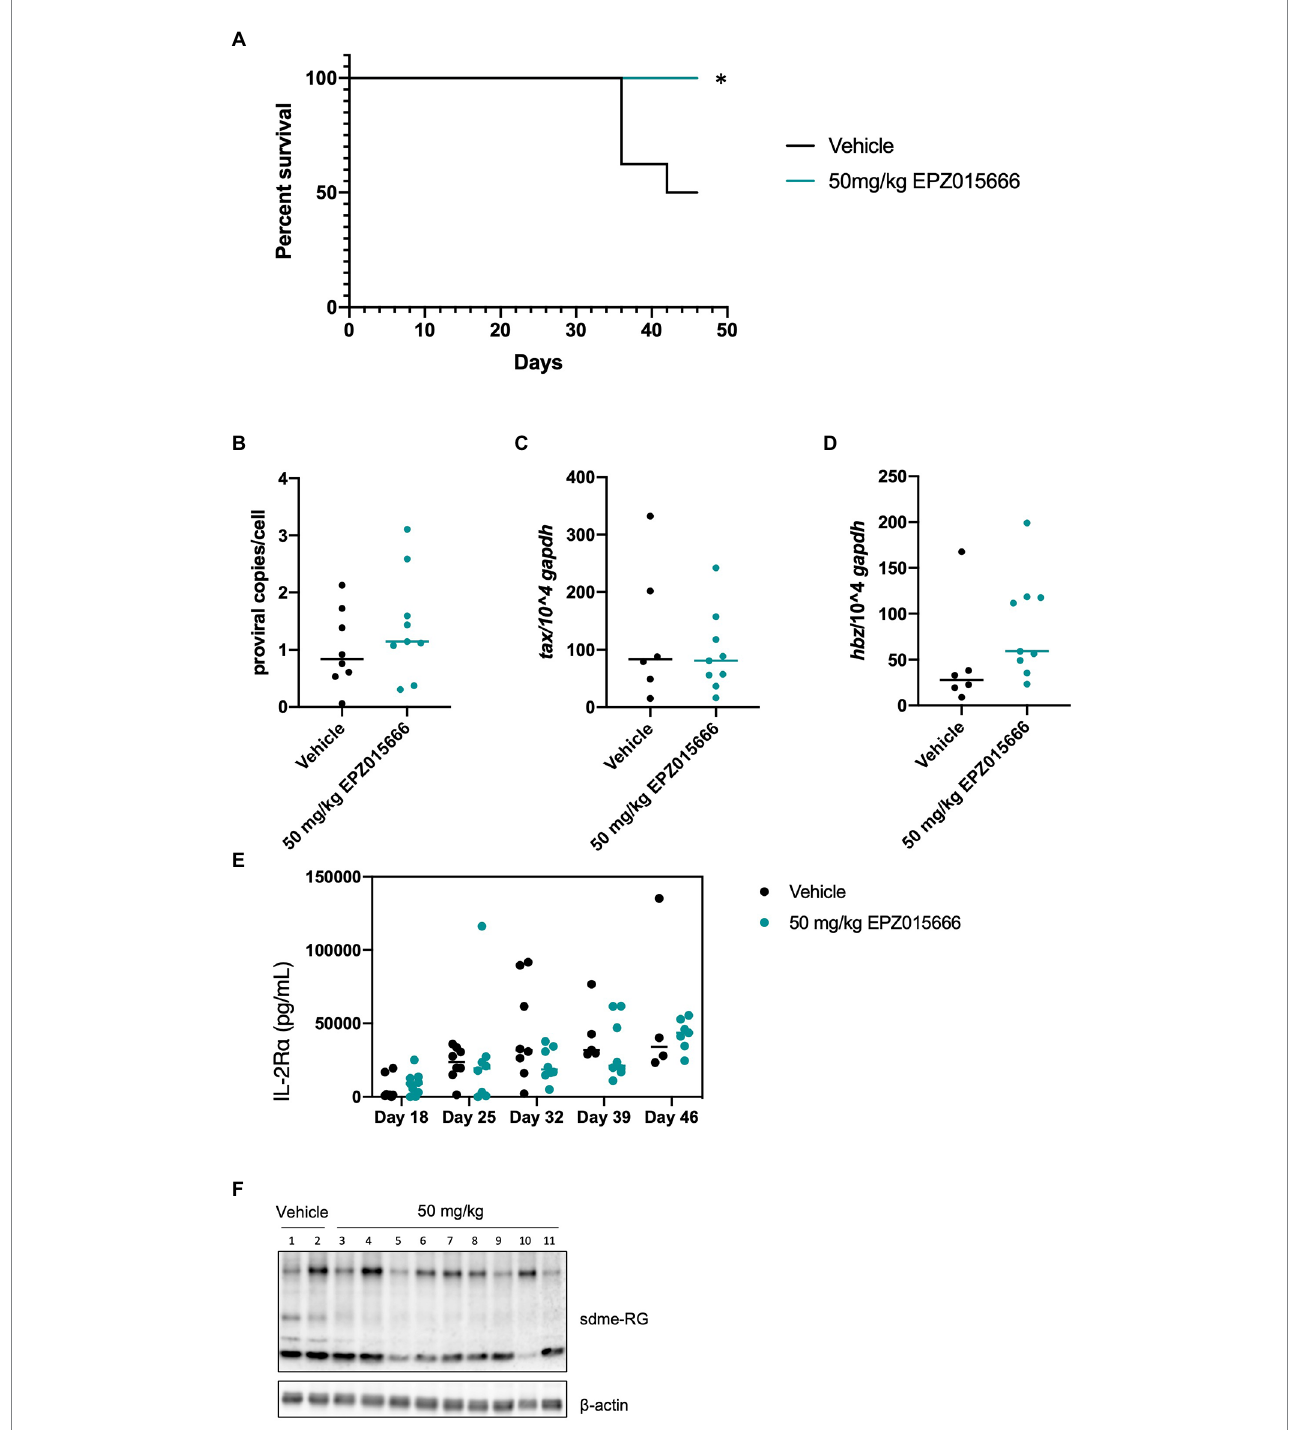
FIGURE 4 EPZ015666 increases survival in HIS mice. HIS mice were intraperitoneally inoculated with 1×10 6 lethally irradiated HTLV-1 producer cells (729.ACH). At day 21 post-infection, mice were bidaily administered EPZ015666 (50 mg kg − 1 ; n = 9) or vehicle (0.5% methylcellulose; n = 8) for the remainder of the study. Mice that had not succumbed to disease were sacrificed at day 46. (A) Percent survival data of each treatment group was represented as a Kaplan–Meier survival curve. Statistical significance was determined using the Log-rank Mantel–Cox test; p < 0.05 (*). (B) Proviral copies, (C) tax transcript, and (D) hbz transcript levels were measured from mouse spleen at the time of necropsy. (E) Human IL-2R α levels were quantitated in mouse serum using an ELISA assay at 18-, 25-, 32-, 39-, and 46-days post-infection. (F) Splenic lysates were collected at time of necropsy and subjected to immunoblot analysis to compare the levels of sdme-RG expression. β -actin was used as a loading